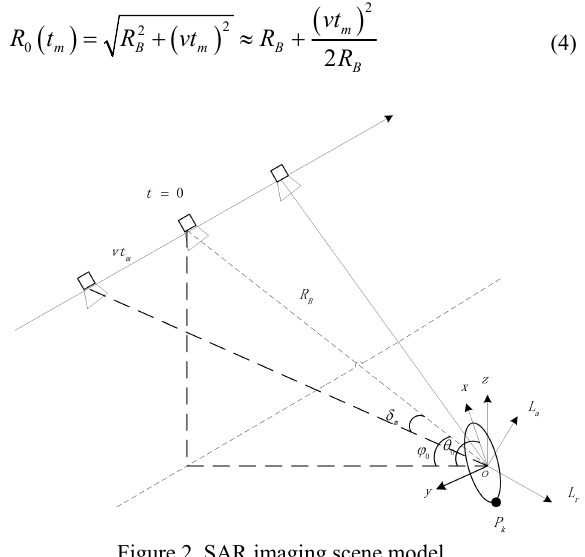
Figure 2. SAR imaging scene